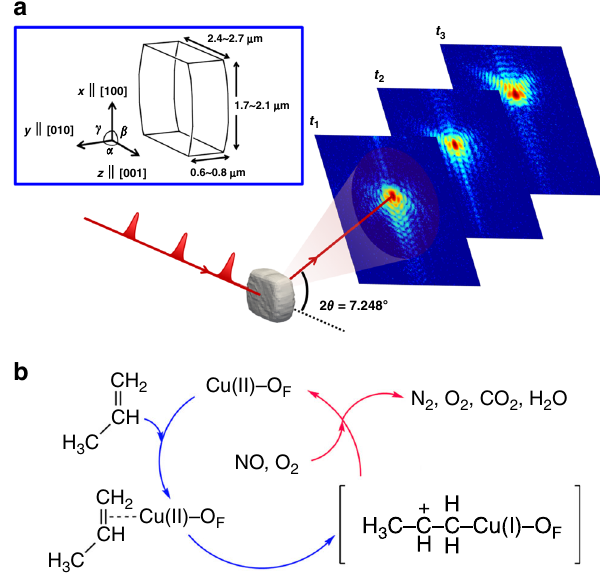
Fig. 1 Schematic of the experimental principles and reactions. a Schematic of the time-resolved BCDI experiment at LCLS. The Cu-ZSM-5 is a monoclinic structure, where α ≅ 90.4° and β = γ = 90°. b Diagram illustrating the catalytic deoxygenation reactions in the Cu-ZSM-5. Two processes are used in this study: (i) propene adsorption (in blue) and (ii) NO x deoxygenation (in red) by inserting NO and O 2 in the presence of adsorbed propenes. In the initial state in N 2 , Cu(II) ions are coordinated to O atoms (O F ) adjacent to Al atoms. During the process (i), the propene double bond coordinates to a Cu(II) ion to form CH 3 CH = CH 2 – Cu(II) 29 . This complex undergoes electron transfer to produce CH 3 CH( + )CH 2 − Cu (I) 28,29 . In process (ii), after a mixture of NO and O 2 is inserted, O 2 oxidizes the hydrocarbon portion of CH 3 CH( + )CH 2 − Cu(I), generating CO 2 and H 2 O, while NO x reacts with Cu(I) to give N 2 and O 2 28